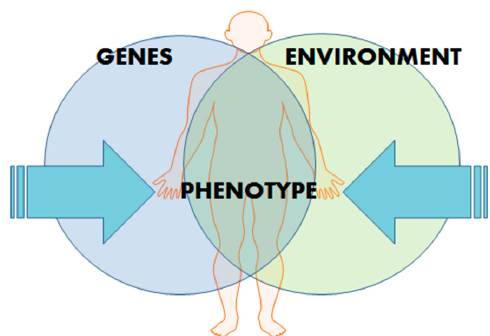
Figure 1. Influences on phenotype manifestation. Development of polygenic conditions, such as essential hypertension (EH), depend on a complex but interactive genetic and environmental system.